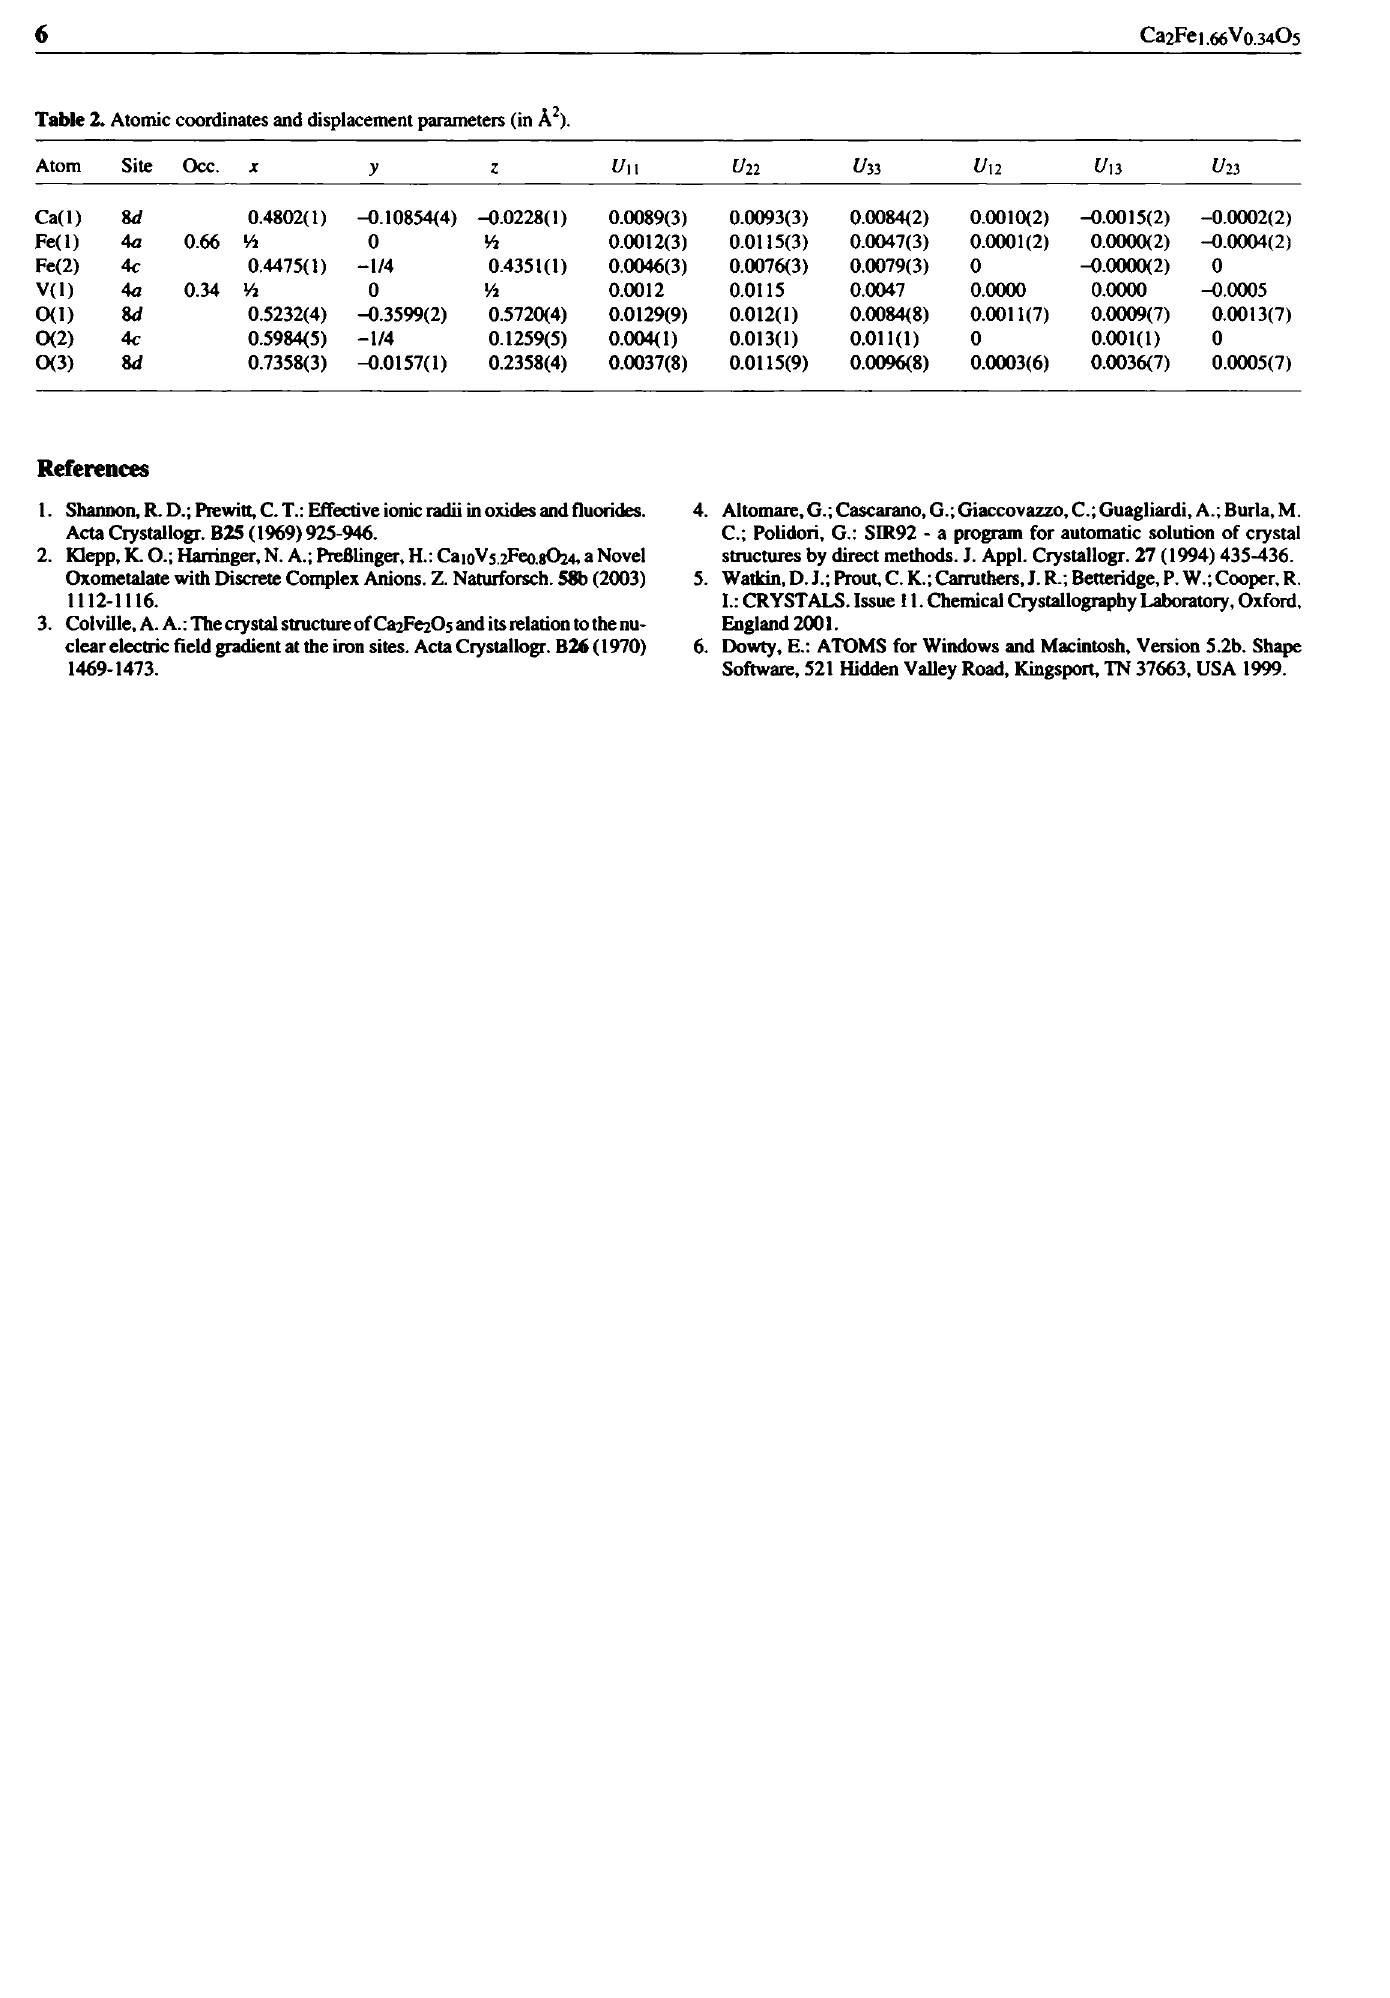
Table 2. Atomic coordinates and displacement parameters (in À 2